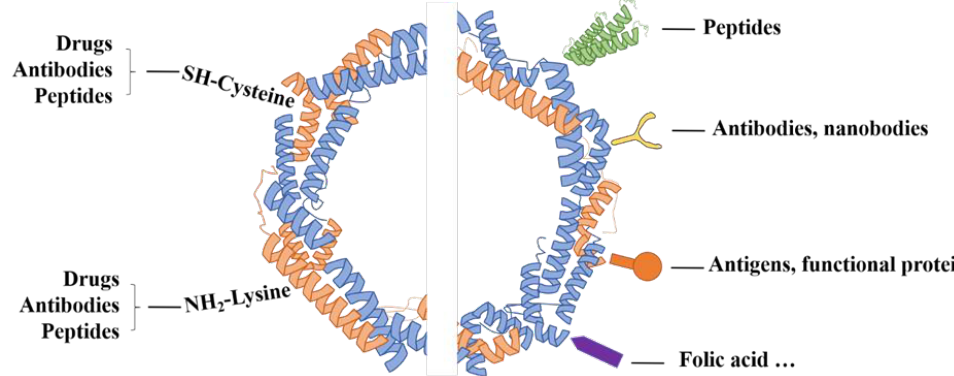
Figure 3. Strategies for surface functionalization of ferritin.